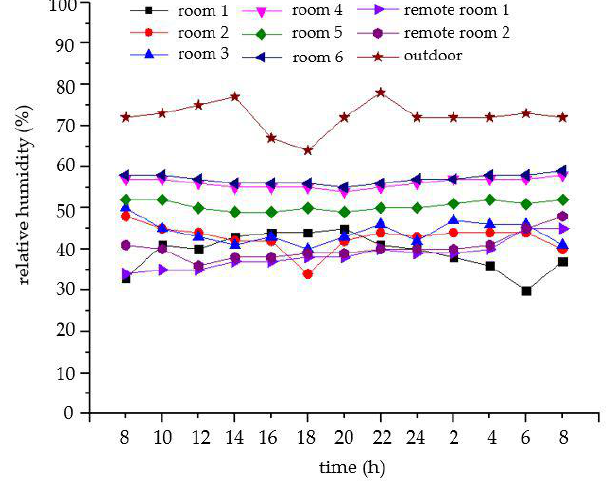
Figure 27. The curve of the relative humidity in different rooms on the same day.